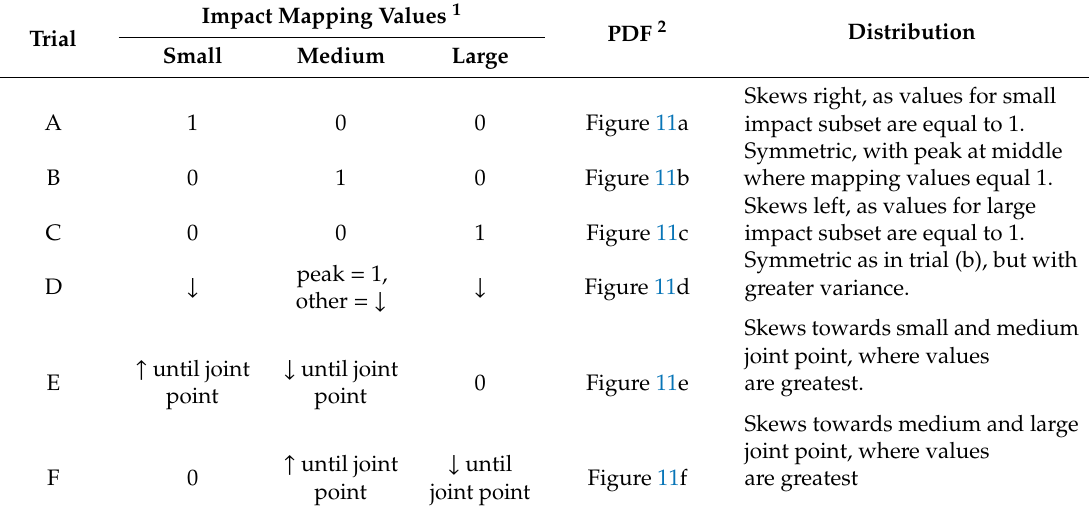
Table 12. Summary of sensitivity analysis experimental parameters on mapping values. Impact Mapping Values 1 Trial Small